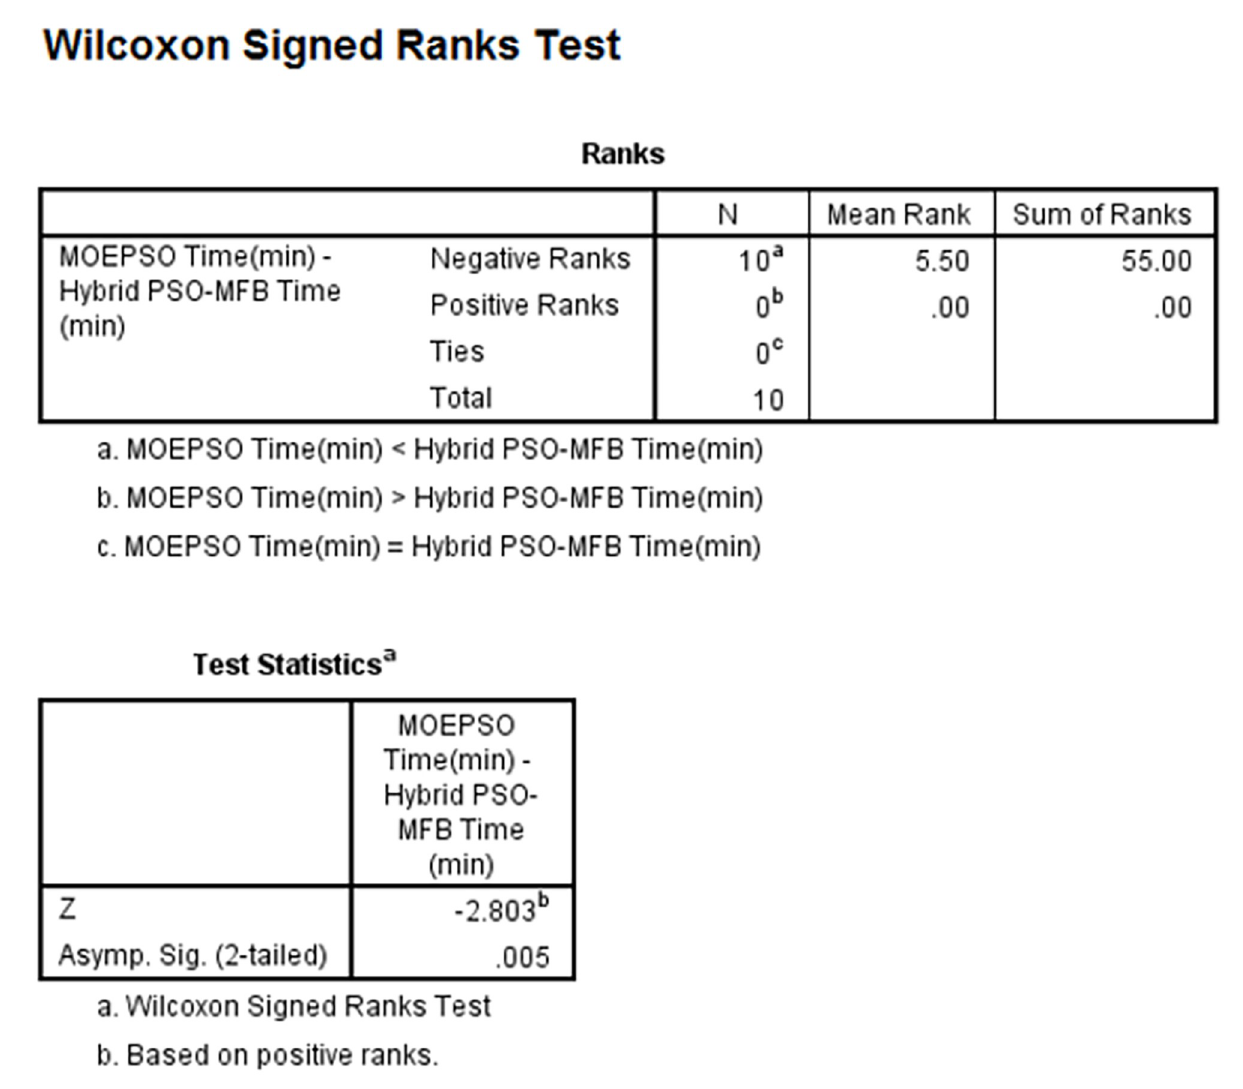
Fig 26. Wilcoxon signed-rank test processing time of MOEPSO-processing time of Hybrid PSO-MFB.